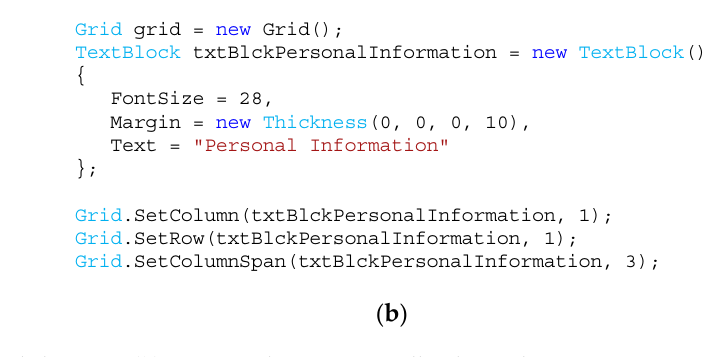
Figure 1. XAML; ( a ) and classic C# ( b ) source code is semantically identical.